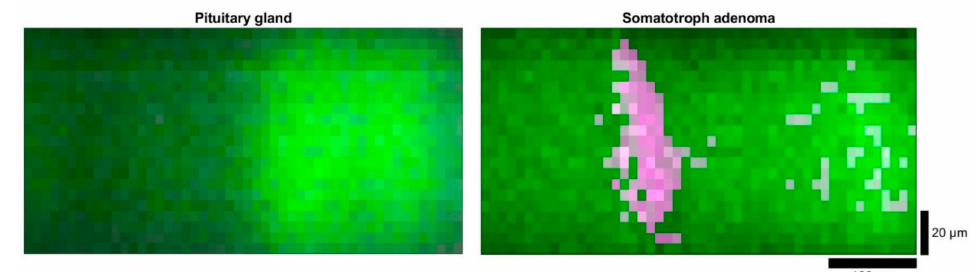
Figure 5. LSRM images of pituitary gland (left) and somatotroph adenoma (right): the spatial intensity di ff erences are given by the Raman bands at 1331 cm − 1 (in magenta) and 1445 cm − 1 (in green). Scale bar: horizontal: 100 µ m, vertical: 20 µ